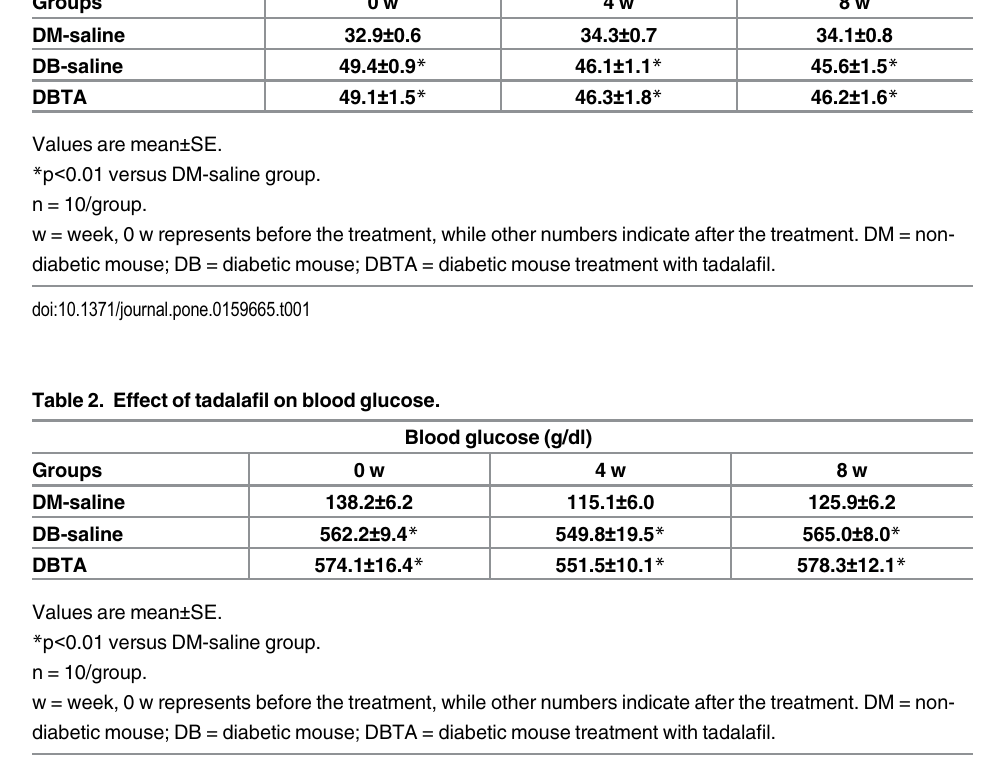
Table 1. Effect of tadalafil on body weight. Groups